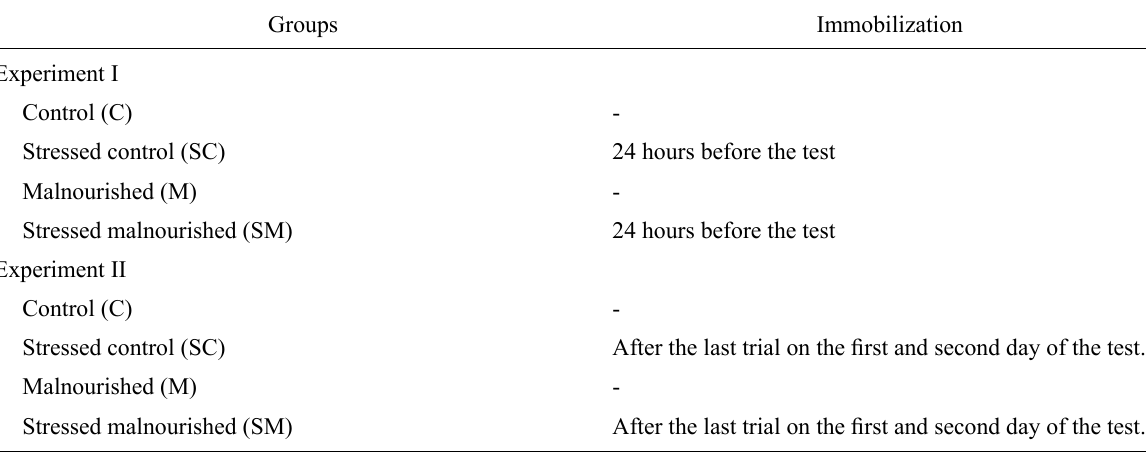
Experimental Groups According to their Nutritional Condition and Exposure to Stress